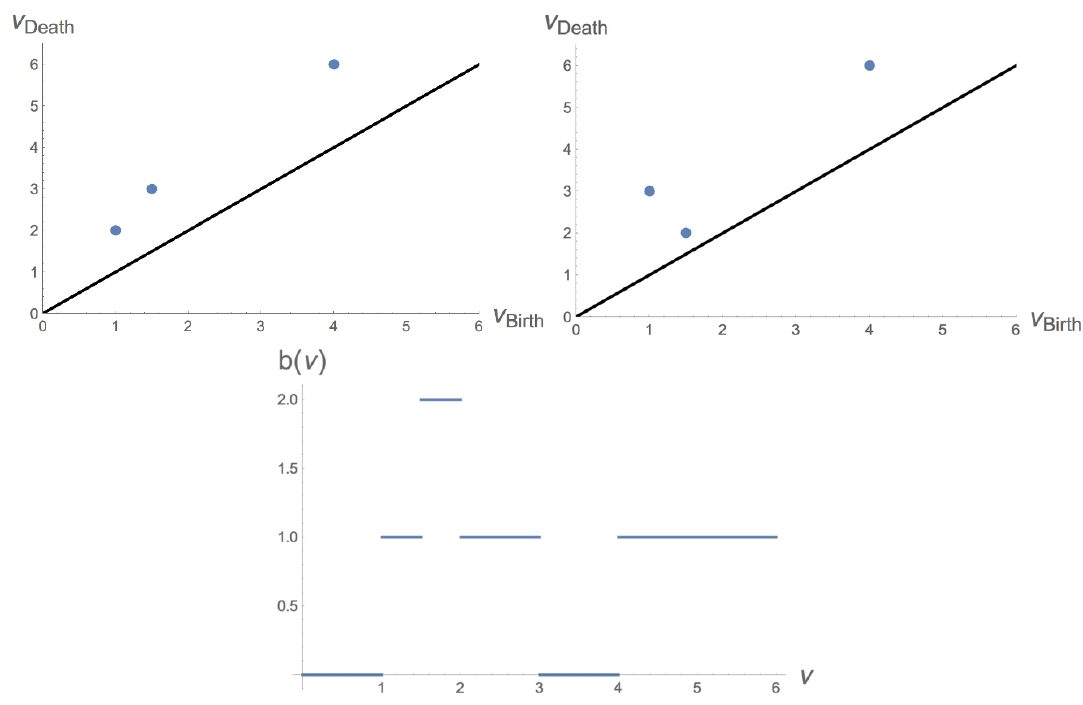
Figure 4 . Two persistence diagrams. To calculate the Betti numbers at a given (cid:12)ltration time, one counts \living" cycles. Persistence diagrams contain more information that the Betti number curves. These two diagrams give rise to the same Betti number curve, shown